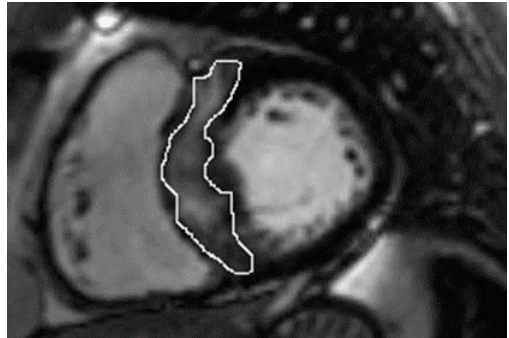
Figure 1. Late gadolinium enhancement (LGE) images show the quantification of the septal burden of replacement fibrosis (circled) via the technique which uses a 5-standard-deviations threshold on consecutive short-axis slices.